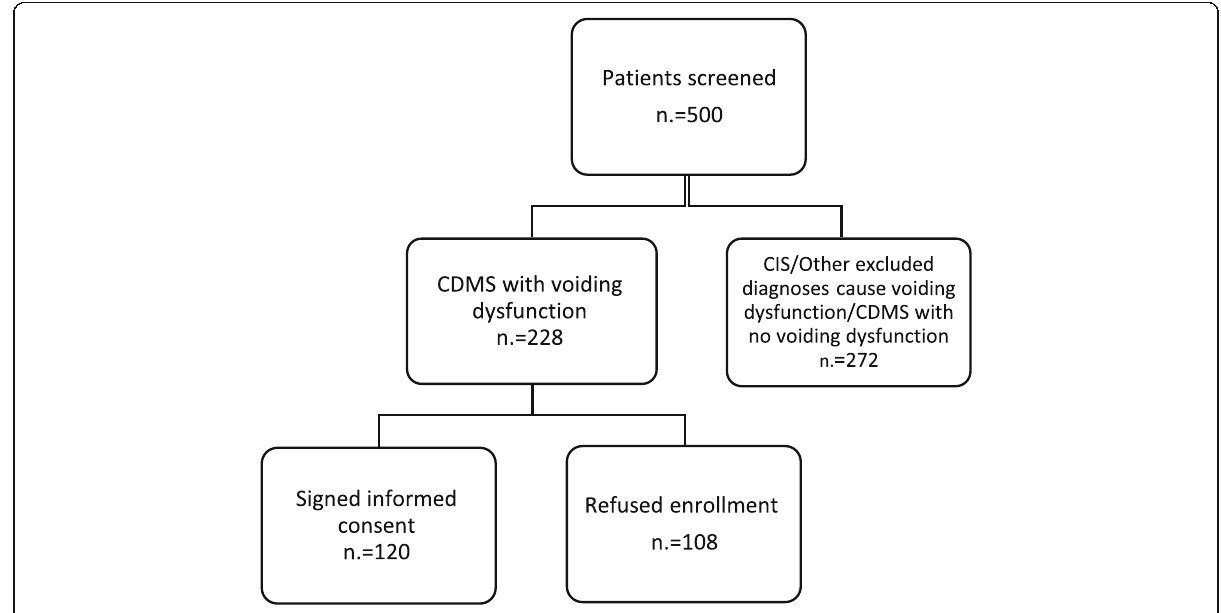
Fig. 1 Disposition of the study population. CDMS, clinically definite multiple sclerosis; CIS, clinically isolated